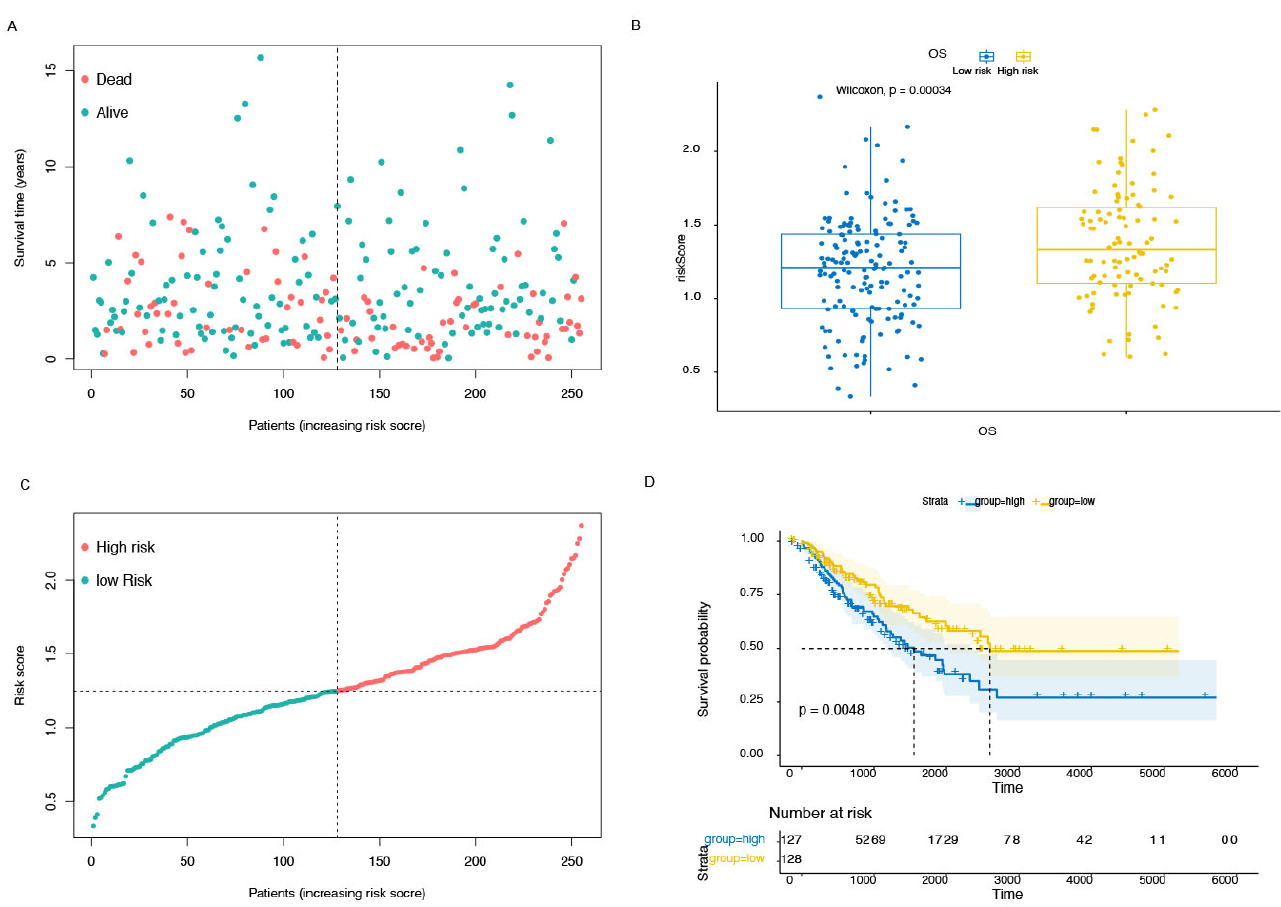
Figure 3. The association survival difference between high- and low-risk groups. ( A , B ) The risk curves and the distribution of patients are ordered according to the risk scores, from low to high. The dots in the lower part indicate the distribution of cases. ( C ) The correlation between overall survival and risk score. ( D ) Survival differences between the high- and low-risk groups in patients with sarcoma from the database. The table below the survival curves shows the number of patients alive in each year.